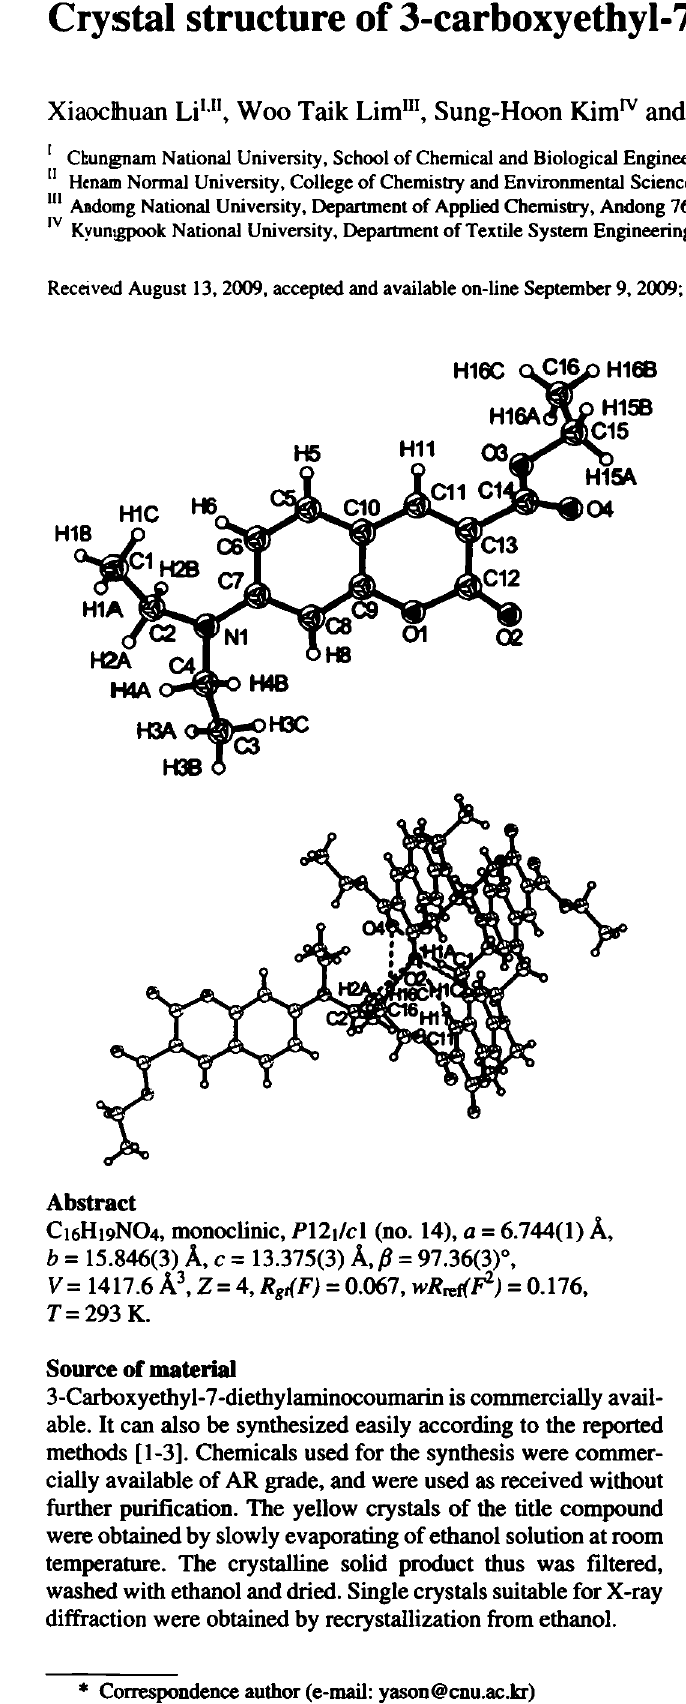
Table 1. Data collection and